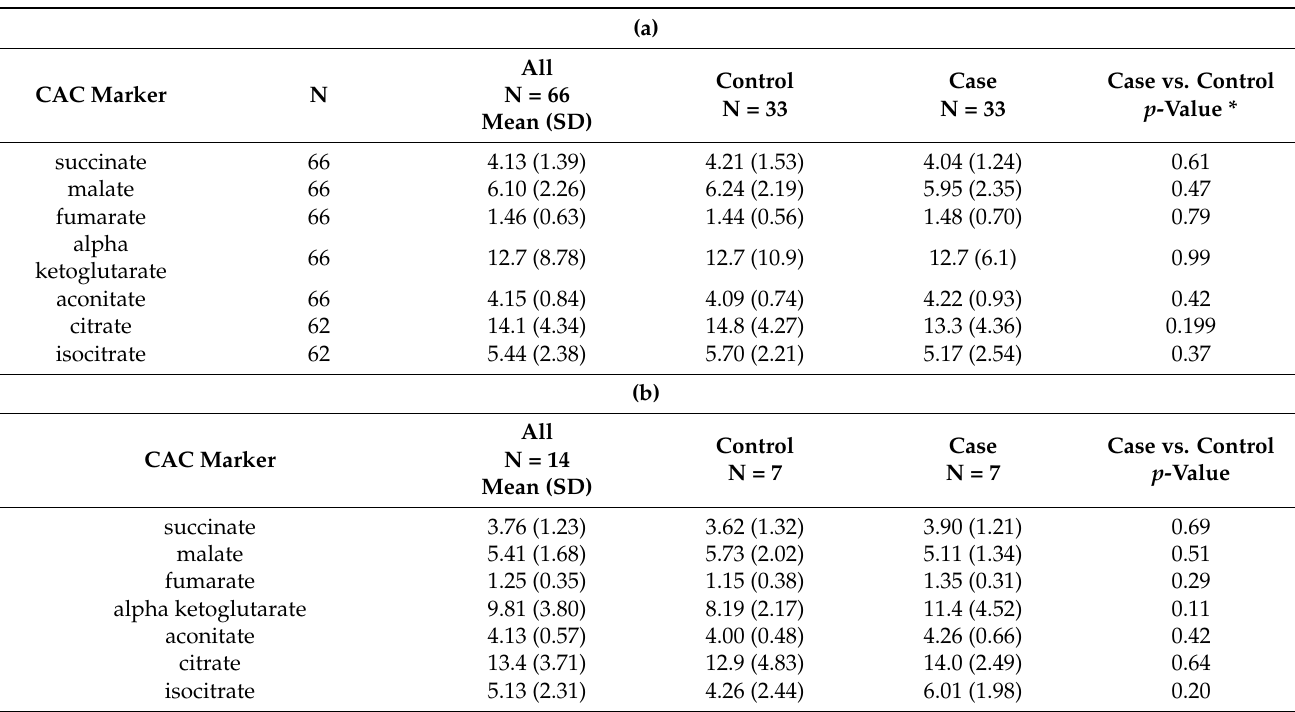
Table 2. (a) Citric Acid Cycle (CAC) markers ( µ mol/L): Full sample. (b) CAC markers ( µ mol/L): PCr-R subset.